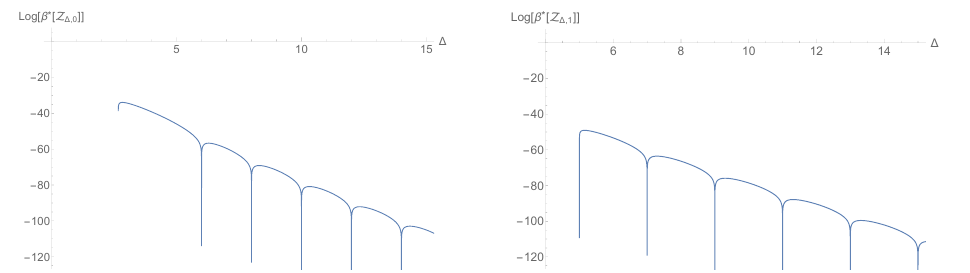
Figure 13. The extremal functional (cid:12) (cid:3) acting on spin-0 (left) and spin-1 (right) primaries at c = 32 and (cid:1) t =